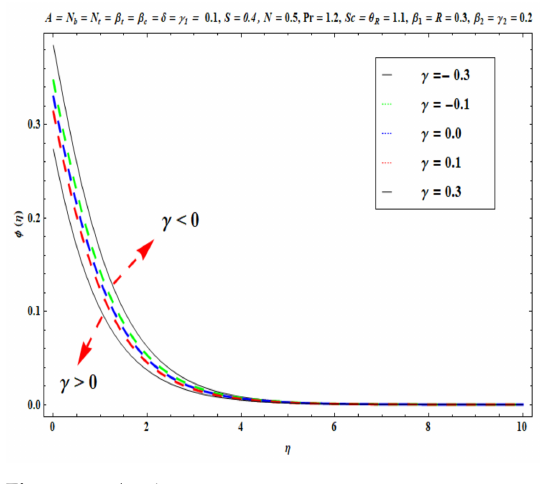
Figure 19. Against γ . Table 4. Numerical values of Nu x Re